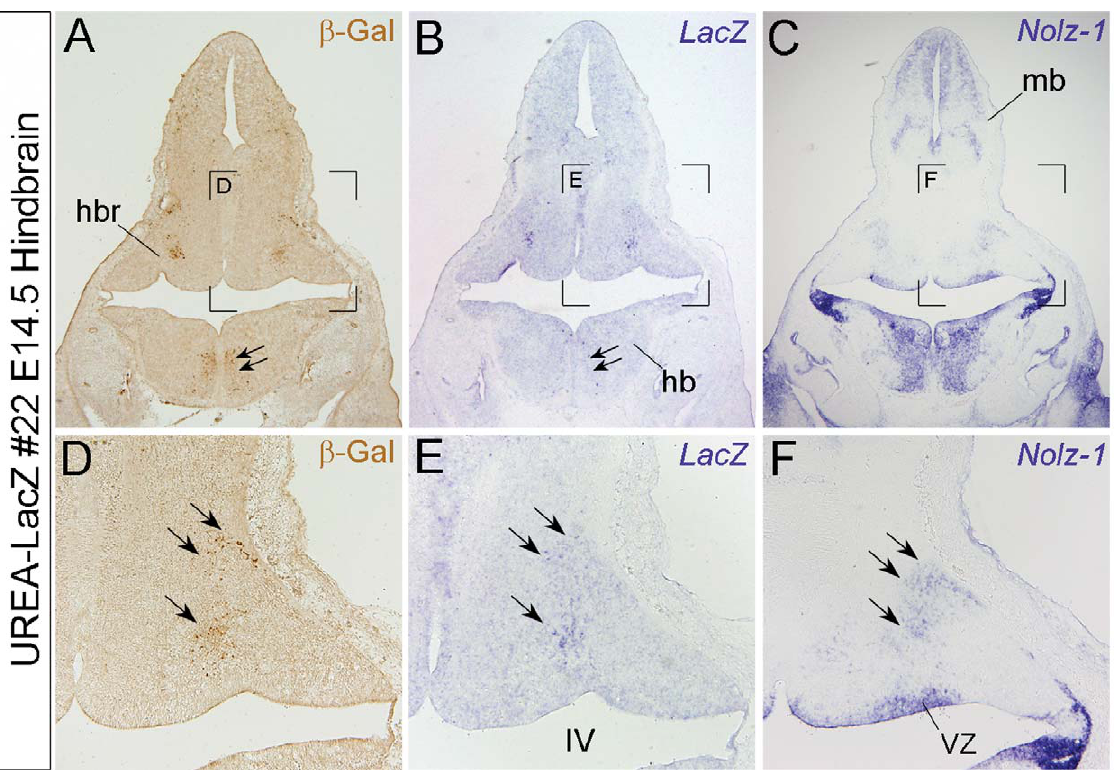
Figure 4. Detection of LacZ expression in a Nolz-1 expressing domain in rostral hindbrain of line # 22 UREA-LacZ embryos. A–C: Expressions of b -gal protein (A), LacZ mRNA (B), and Nolz-1 mRNA (C) on coronal hindbrain sections of line # 22 E14.5 UREA-LacZ embryo. D–E: High magnification views of the bracketed regions in A–C, respectively. Expressions of LacZ mRNA and b -gal protein are both detected in a differentiated domain of rostral hindbrain (triple arrows in D, E) where endogenous Nolz-1 mRNA is expressed (F). LacZ expression is, however, absent in the nearby Nolz-1-expressing ventricular zone (vz, F). Double arrows in A and B indicate a domain in which b -gal expression is detected with little LacZ mRNA expression. IV, fourth ventricle; mb,